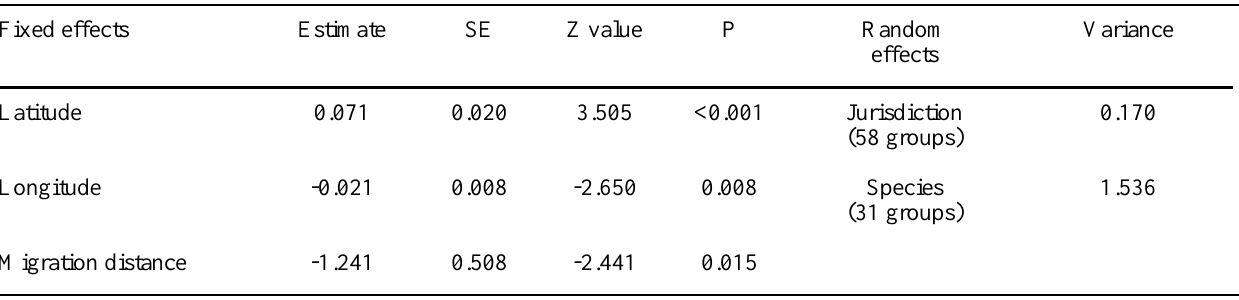
Table 3 . Parameter estimates from a generalized linear mixed model (logit link, binomial errors) assessing the effects of latitude, longitude, and migration distance (reference category, long distance) on the binomial trend variable (decreasing vs. increasing/no